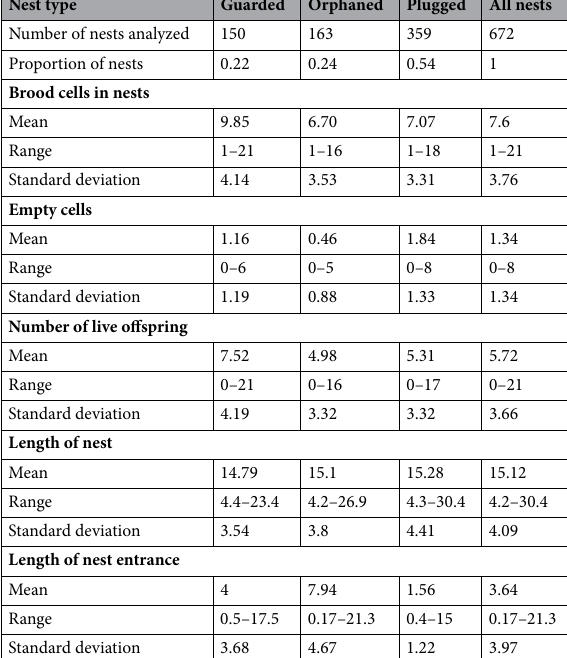
Table 3. Comparison between guarded, orphaned, and plugged full brood